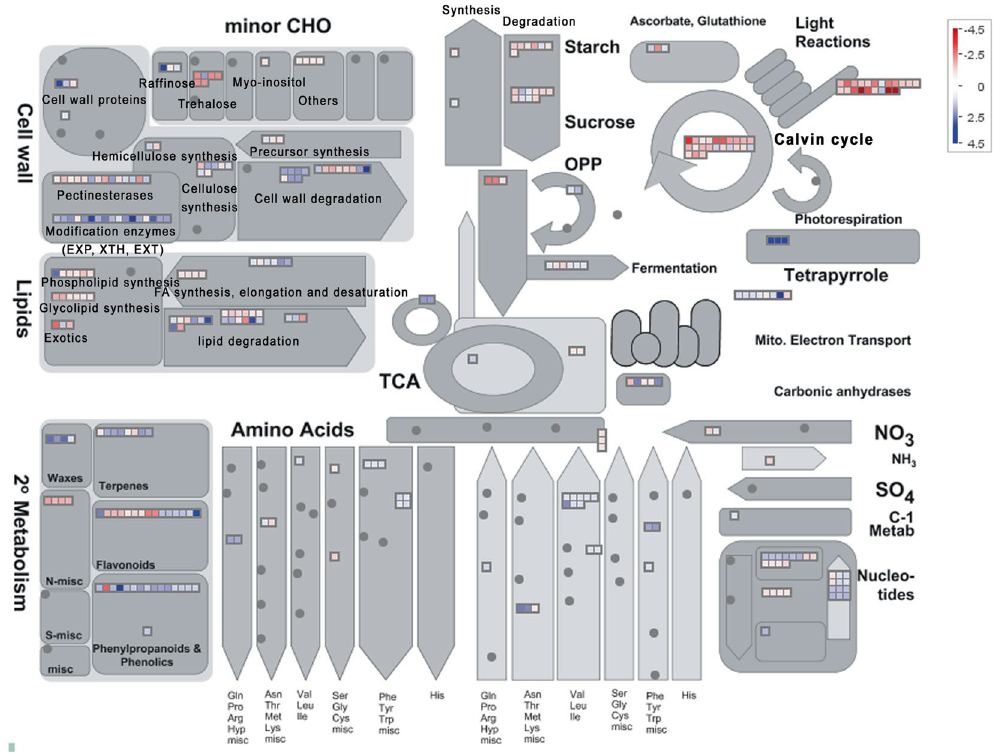
Figure 6. Overview of the metabolic profiles of the differentially expressed transcripts in the phyA phyB mutant by MapMan. Transcripts showing different fold-changes between the phyA phyB mutant and wild-type (WT) rice were mapped in different colors. Red boxes indicate that transcripts were down-regulated in the phyA phyB mutant, while blue boxes indicate that transcripts were up-regulated in the double